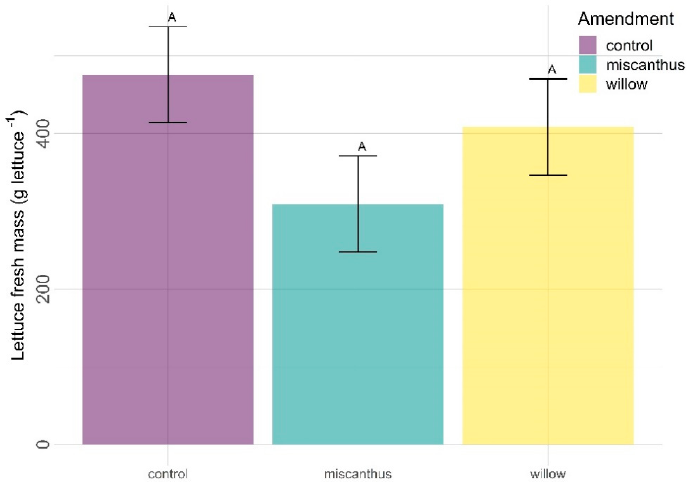
Figure 3. Lettuce fresh mass per plant as a function of soil amendment. Different letters indicate significance at p < 0.05 using the post hoc Tukey HSD